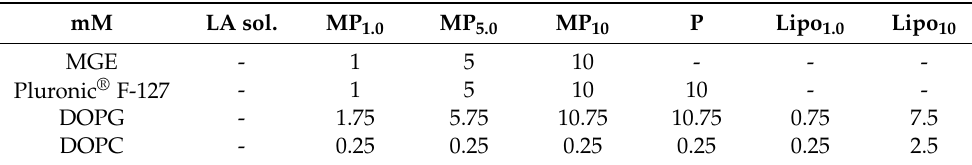
Table 2. Composition of the prepared formulations. mM LA